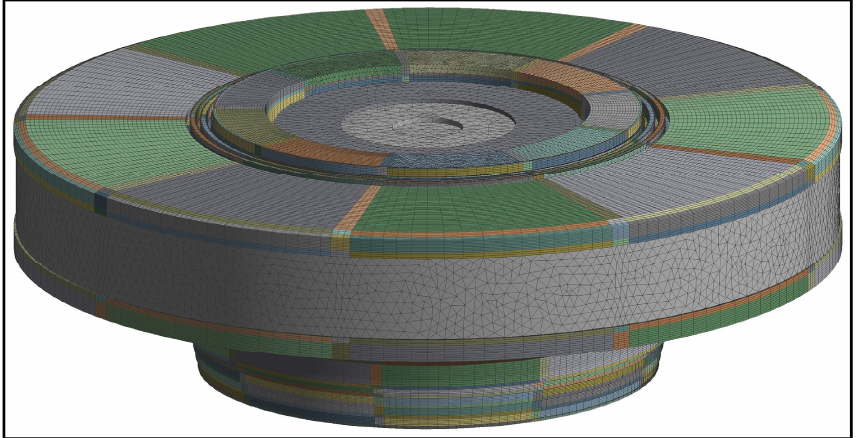
Figure 3. Finite element model of fluid–structure coupling modal analysis of runner.